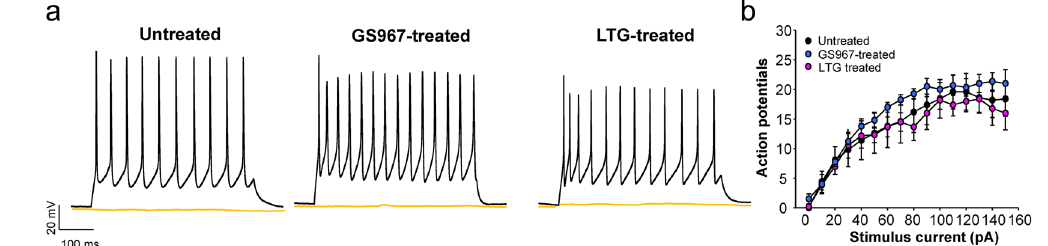
Figure 2. GS967 treatment of Scn1a + / − mice does not affect bipolar neuron excitability. ( a ) Representative action potentials in response to either 0 pA (orange traces) or 50 pA stimulus (black traces) recorded from bipolar neurons acutely isolated from untreated ( left ), GS967-treated ( middle ) and lamotrigine (LTG)-treated (right) Scn1a + / − mice. ( b ) Summary data plotting number of action potentials against stimulus current. Error bars represent SEM, with n = 5–7 per group. There were no significant differences among the groups at any stimulus current level.